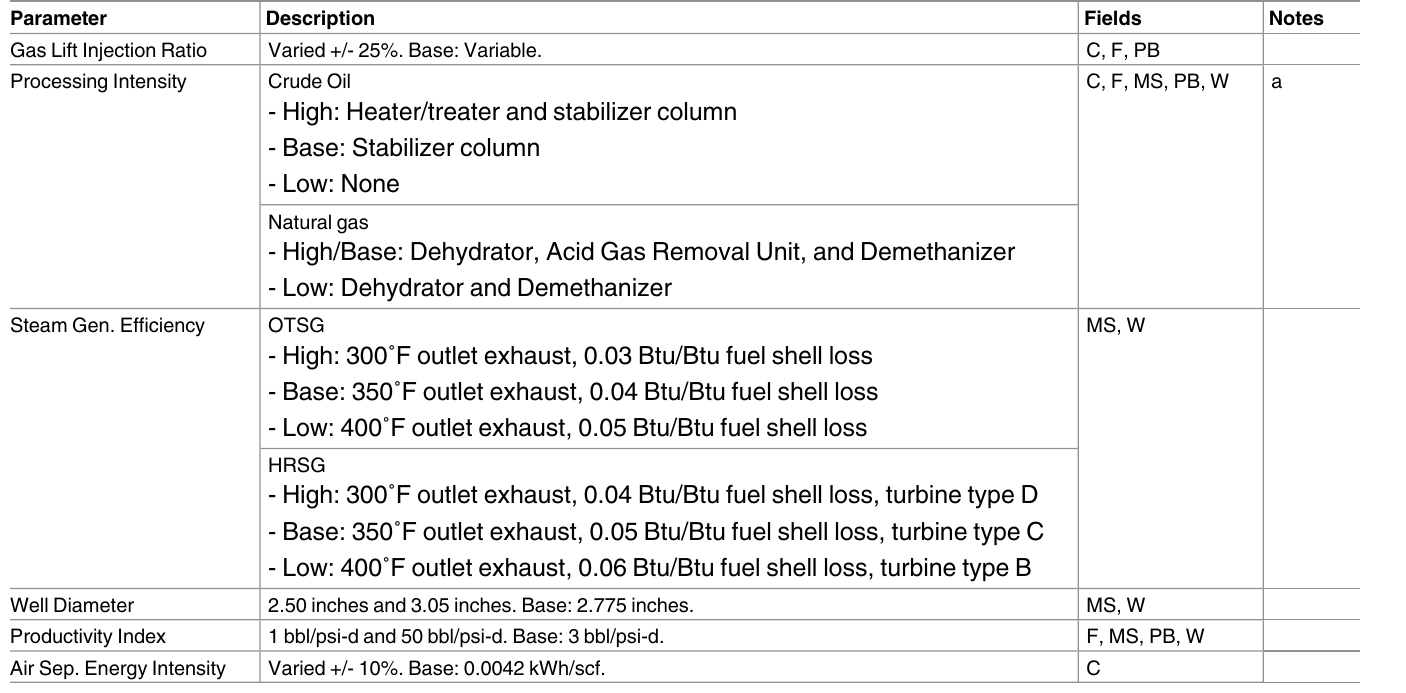
Table 6. Summaryof sensitivity analysis parameters (C = Cantarell, F = Forties, MS = Midway-Sunset, PB = Prudhoe Bay, W = Wilmington).